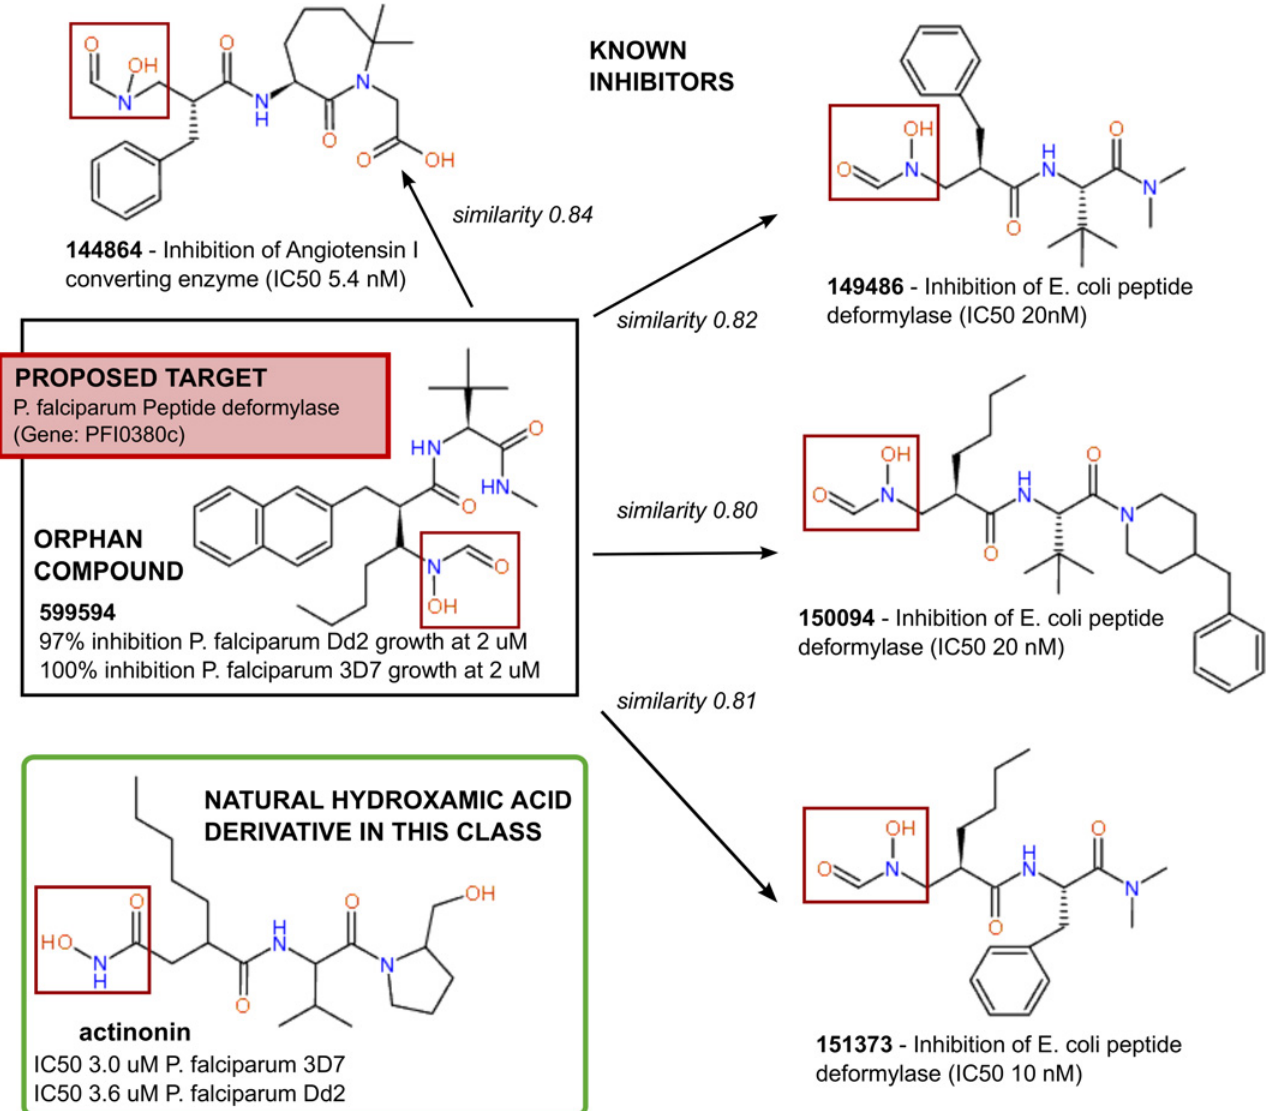
Fig 6. Suggesting targets for orphan compounds: example 2, peptide deformylase. Following the strategy described in the text, and visualized in Figs 4 and 5, based on the functional affiliations of the chemical similarity neighborhood of orphan compound 599594 (TDR Targets ID), the target of this compound is proposed to be a peptide